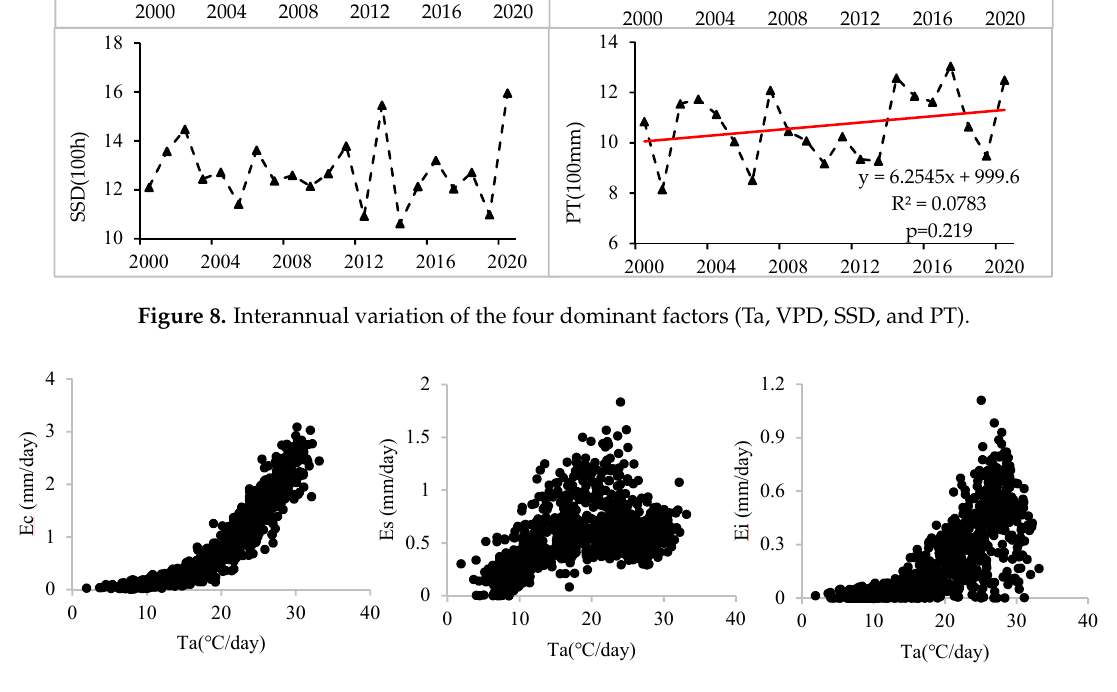
Figure 9. Trends of Ec, Es, and Ei as Ta increase (8-day mean scatter plot).